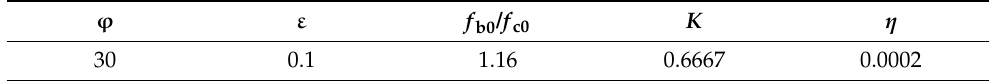
Table 2. Parameters of concrete damaged plasticity constitutive